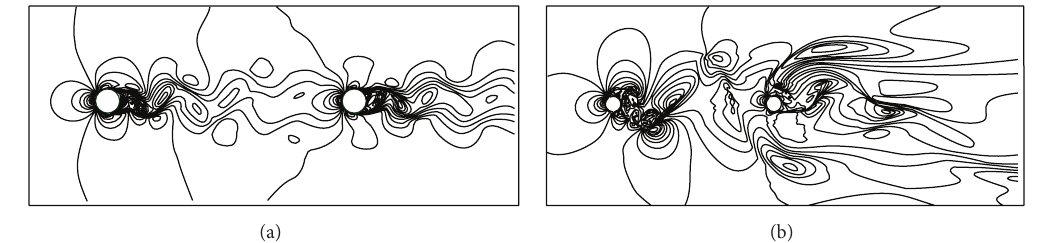
Figure 4: Comparison of the vorticity contours without rivulets (a) and with rivulets (b).